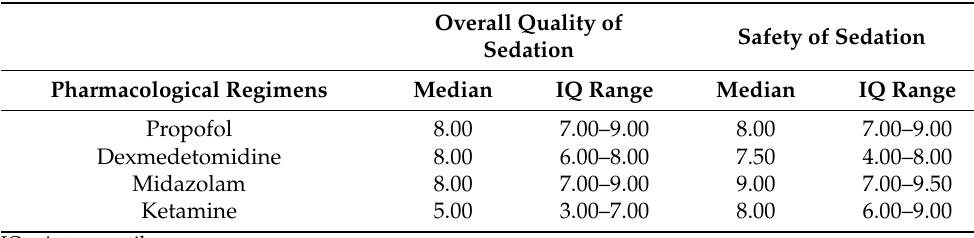
Table 1. Nurses’ perception about overall quality of sedation and safety using four different pharma- cological